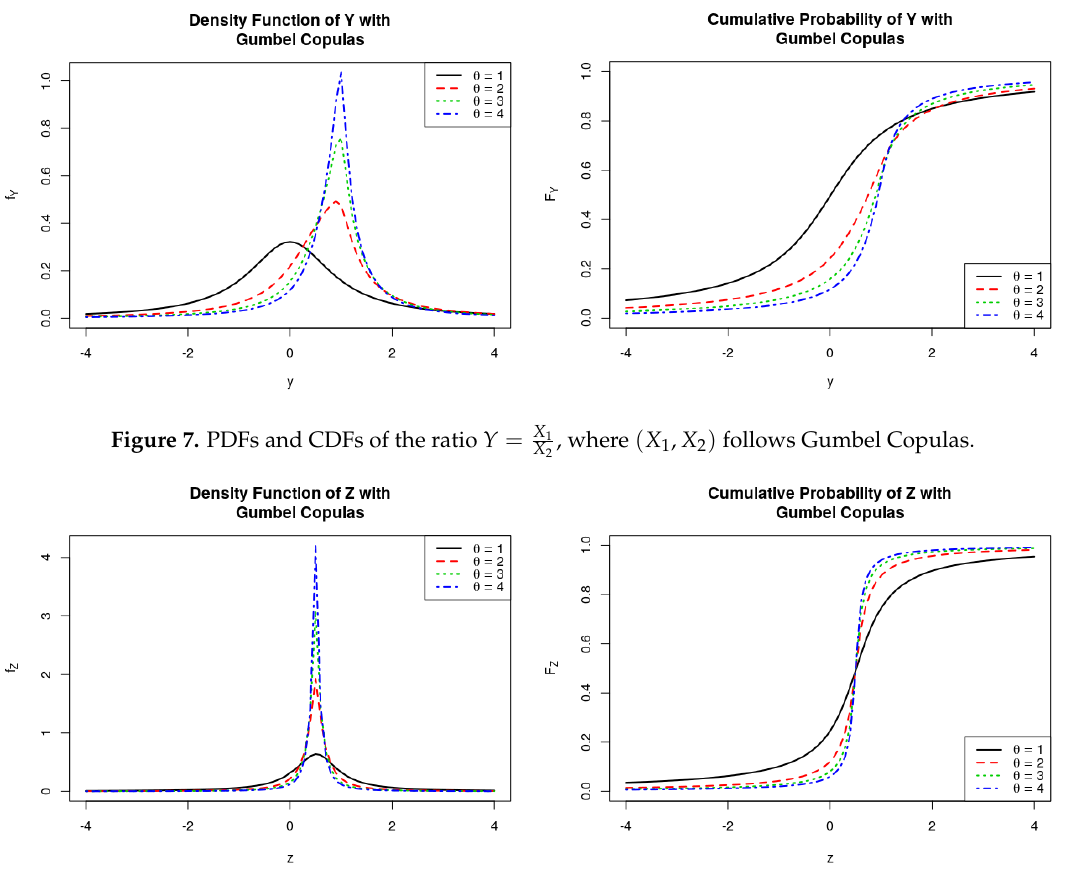
Figure 8. PDFs and CDFs of the ratio Z = X 1